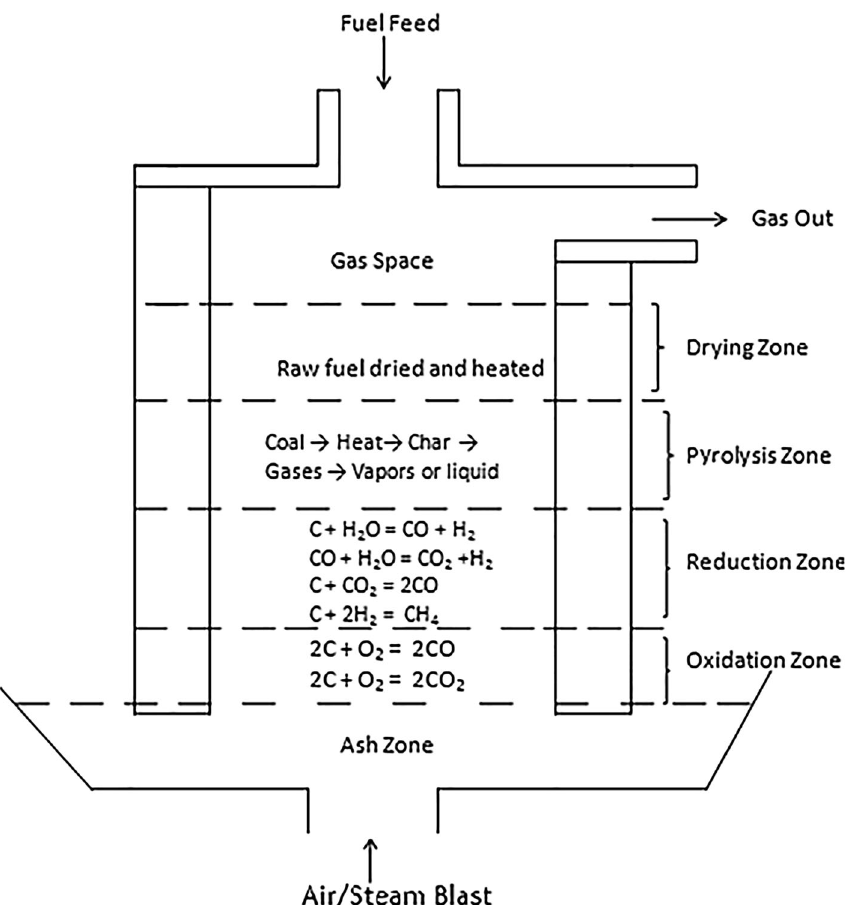
Fig. 2 Exothermic and endothermic reactions in updraft